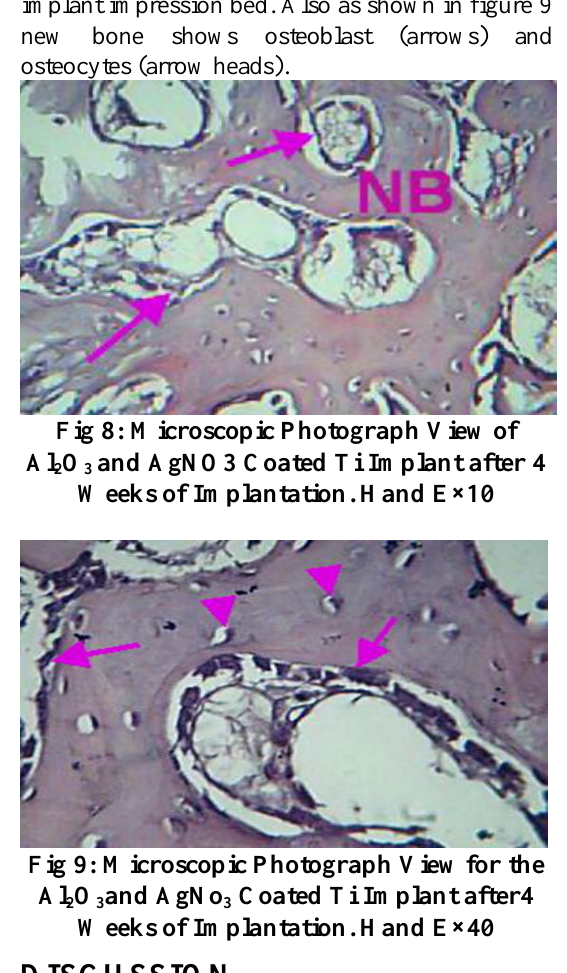
Fig 6: Microscopic Photograph View ofAl O and AgNo Coated Ti Implant after 2 2 3 3 Weeks of Implantation. Hand E×10